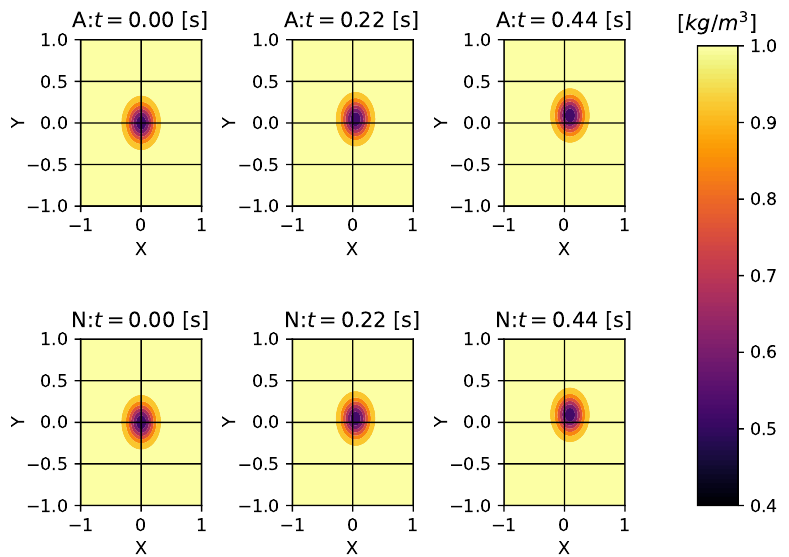
Figure A10. Verification of the compressible Euler equations solver by comparing numerical and analytical solutions over a series of time